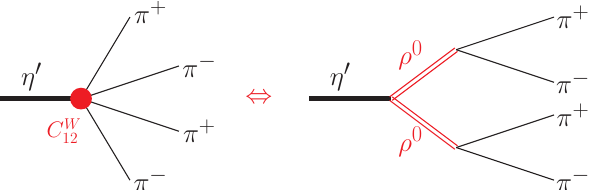
Fig. 2. Left: The vertex (red circle) denotes the (local) counter term of O ( p 6 ), see [9]. Right: π + π − pair saturation by ρ 0 mesons. Analogous diagrams apply for the case η ′ → π + π − 2 π 0